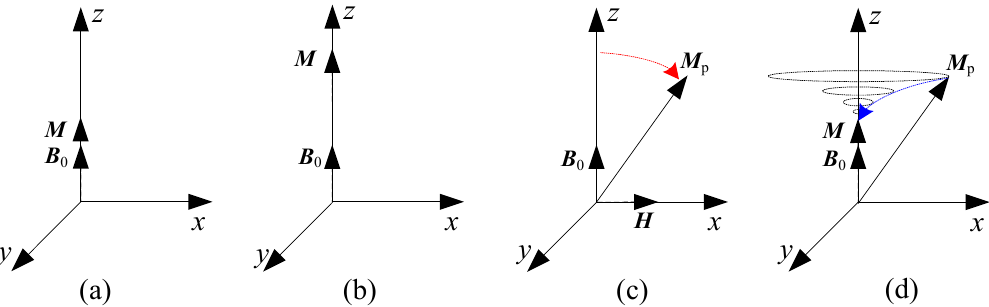
Figure 3. Enhancement and deflection of proton magnetization. ( a ) Initial state; ( b ) enhancement; ( c ) deflection; ( d ) rotating.